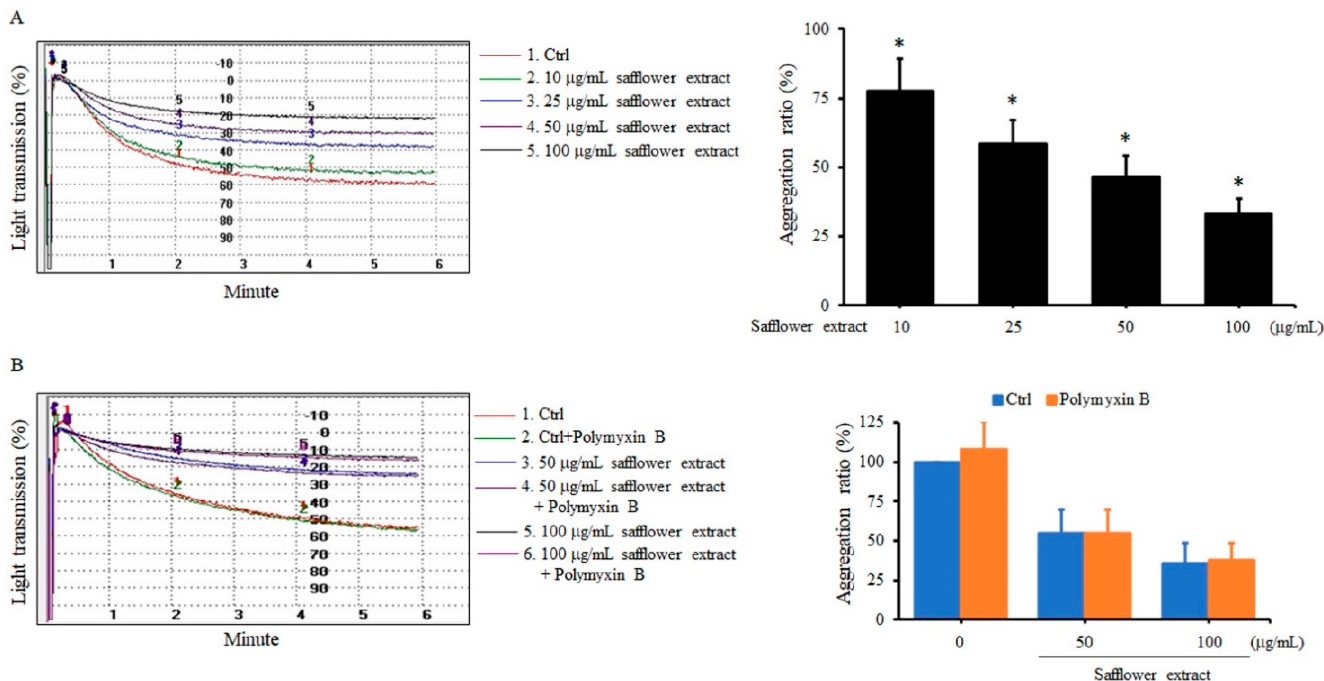
Figure 1. Safflower extract inhibited platelet aggregation. PRP was treated with different concentrations of safflower extract ( A ) or treated with 50–100 µ g/mL safflower extract and polymyxin B ( B ). ADP was added and analyzed by an aggregometer. * p < 0.05 compared with the control group.